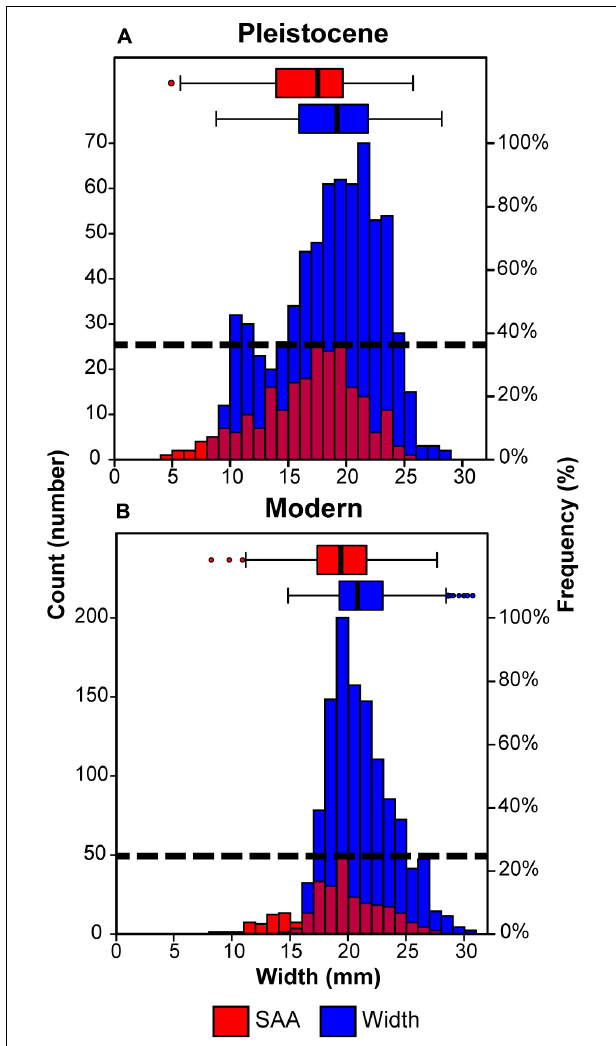
FIGURE 4 | Results of Pleistocene (A) vs. modern (B) body size and size at attack (SAA) for T. funebralis . Boxplots show differences in gastropod body size and size at attack (SAA) for both the Pleistocene and modern samples (see Table 1 for Wilcoxon rank sum test results). Boxes = upper and lower quartiles, central lines = medians, whiskers = min/max data, circles = outliers. Histograms show distribution of SAA (red) and gastropod body size (blue). Relative positions of the distributions of SAA and body size between Pleistocene and modern samples can be compared based on Figure 3 , with results described in Table 3 . The y -axes (counts or number of observations in that size class) are not scaled, as Pleistocene and modern sample sizes were different. Dotted horizontal lines indicate the maximum frequency of repair scars in any size bin, with fewer repairs on modern gastropods. Maximum SAA, as well as relative position of the distributions of SAA vs. body size are similar between both the Pleistocene and modern (see Table 3 ), suggesting that any differences in repair frequency represent changes in the number of crab attacks, rather than a difference in crab relative success. If anything, there are more repairs on smaller gastropods in the modern ( Table 3 ), which should increase the expected frequency of repairs, yet there are still fewer repairs observed in the modern. While the increased frequency of comparatively small gastropods between 11 and 13 mm in the Pleistocene may be the result of time averaging, it is important to note that this does not influence the relative position of the distributions of SAA compared to body size (see also Table 3 ), nor the observation of fewer repairs in the